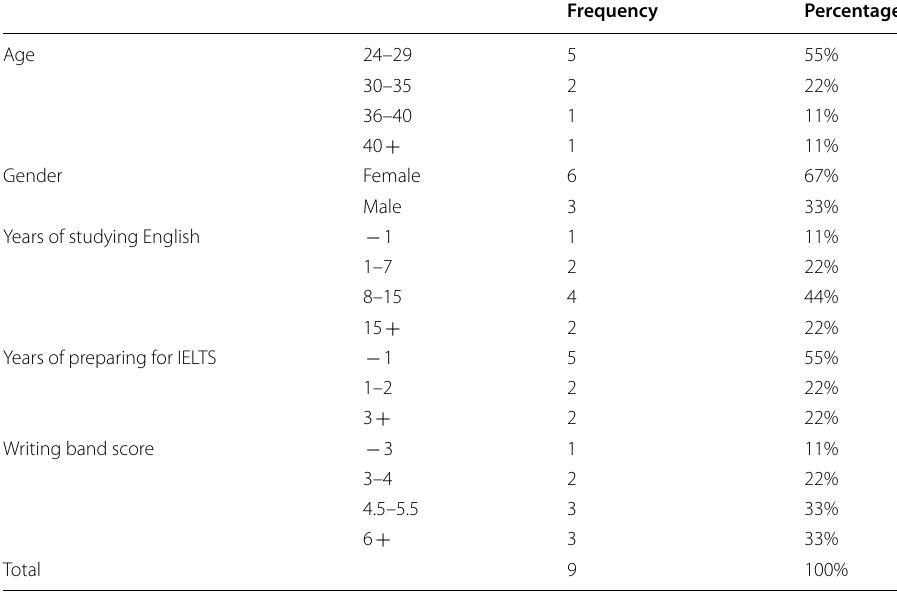
Table 3 Demographic information of the participants in the